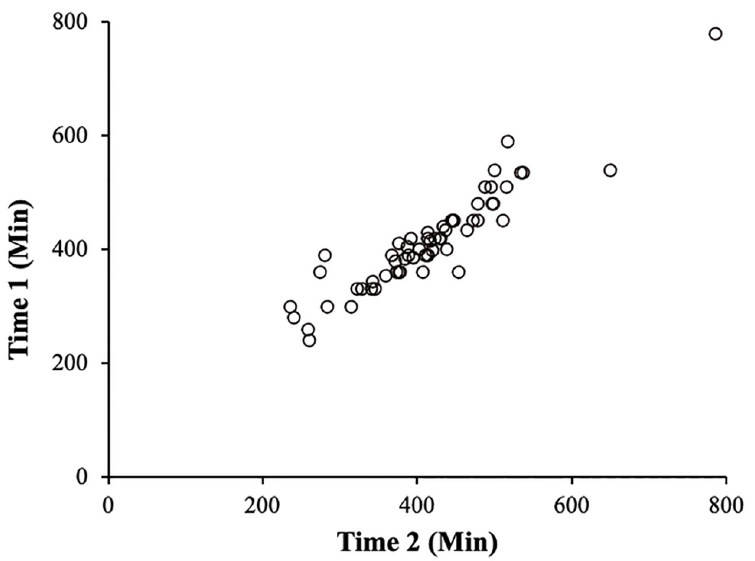
Fig 8. Scatter plot using Pearson’s correlation